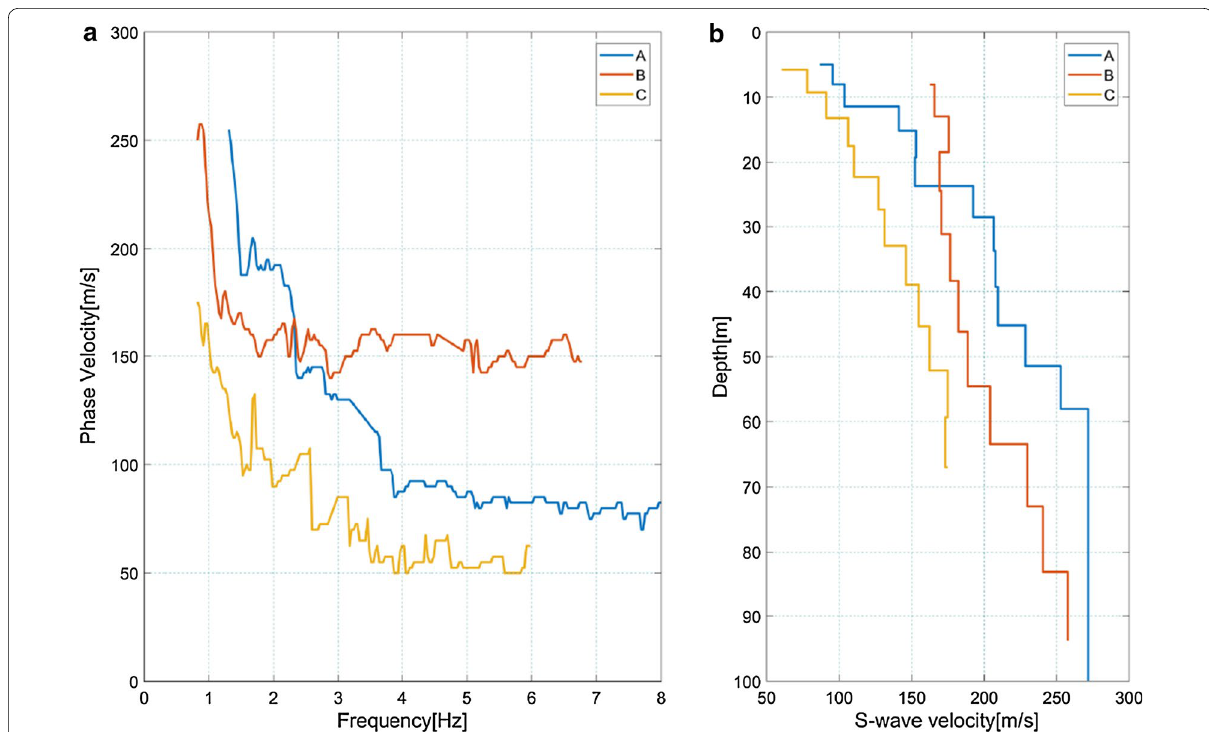
Fig. 2 a Phase velocity dispersion curves and b S-wave velocity–depth profiles at locations A, B, and C (see Fig. 1c for